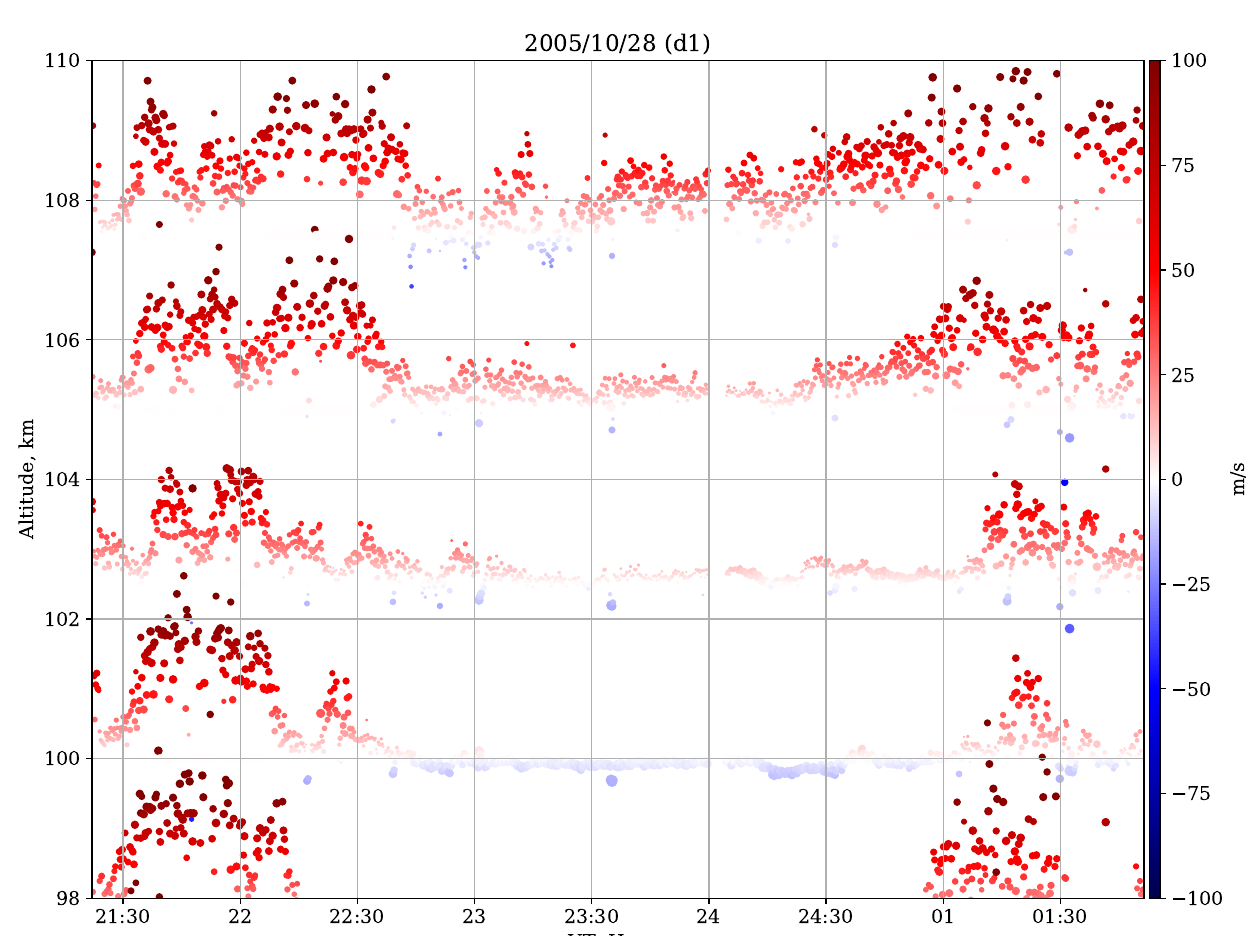
Figure 2. Zoomed RTV plot of FAI-E in 98–108 km altitudes on 28 October 2005. Circle size is proportional to the signal-to-noise ratio and the altitude modulation is proportional to the Doppler velocity